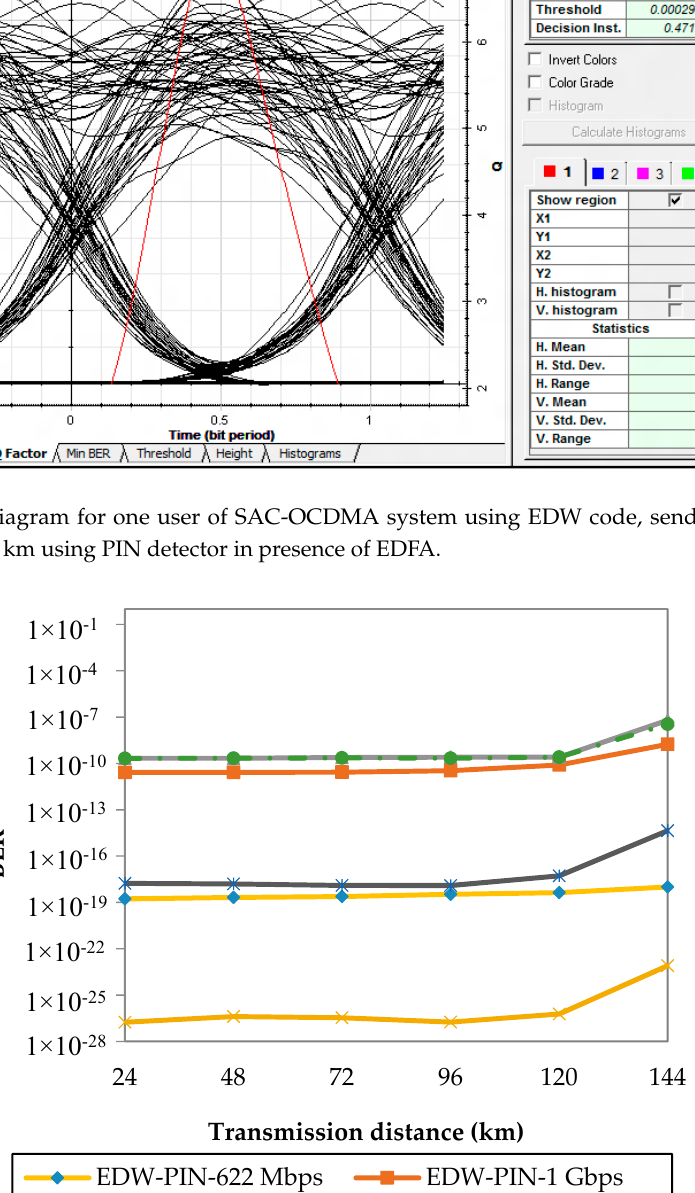
Figure 9. BER with transmission distance for SAC-OCDMA using different codes and SPD detection technique at different bit rates in the presence of DCF and EDFA.